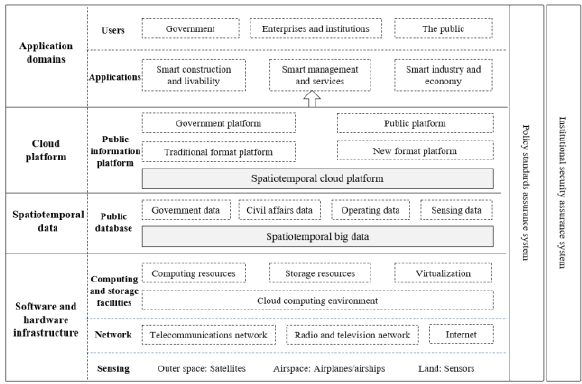
Figure 2. Smart city conceptual